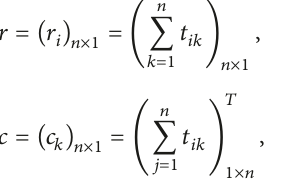
Algorithm II. DEMATEL-based method for ensuring weight- ing vector 𝜔 𝐴𝐼 .